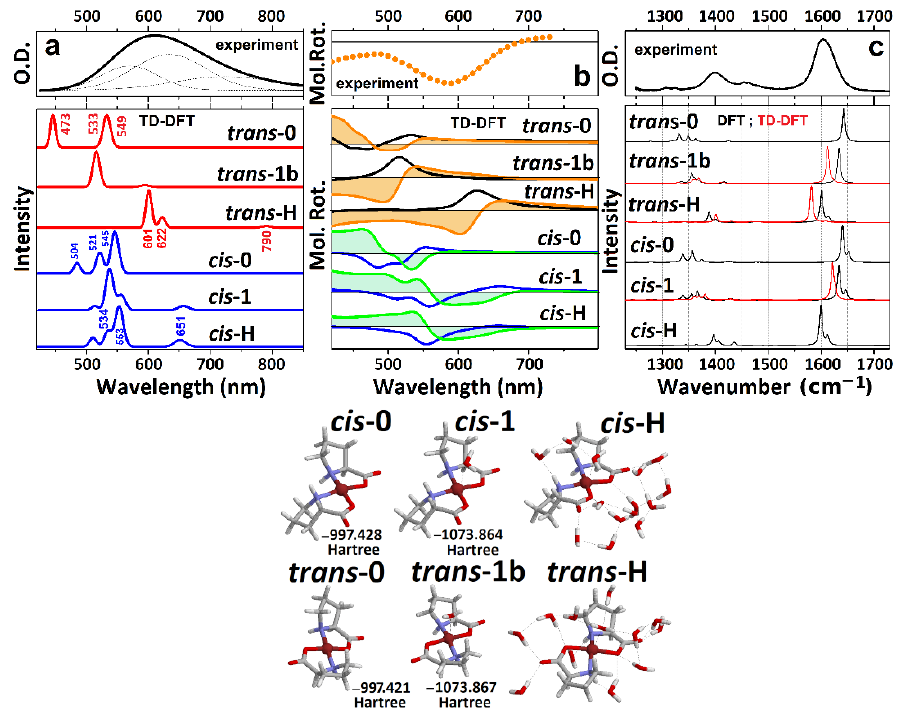
Figure 2. ( a ) Experimental optical absorption spectrum of the Cu(proline) 2 complex and calculated responses of the model systems, as shown at the right side. For clarity, the spectral dispersions are calculated using convolution with a narrow line shape. ( b ) Experimental ORD spectrum and theoretical CD (black lines correspond to trans -complexes and blue lines to cis -complexes) and ORD (orange filled profiles correspond to trans -complexes and green filled profiles to cis -complexes) responses for the model systems calculated as described in Materials and Methods. ( c ) Experimental FTIR spectrum and calculated IR responses for the model systems in the electronic ground state (black lines) and in the first excited electronic state (red lines). For clarity, the spectral dispersions are calculated using convolution with a narrow line shape. Right side: images of the model molecular systems under cis and trans geometries: numbers next to the structures refer to energies after optimization in the ground electronic state.